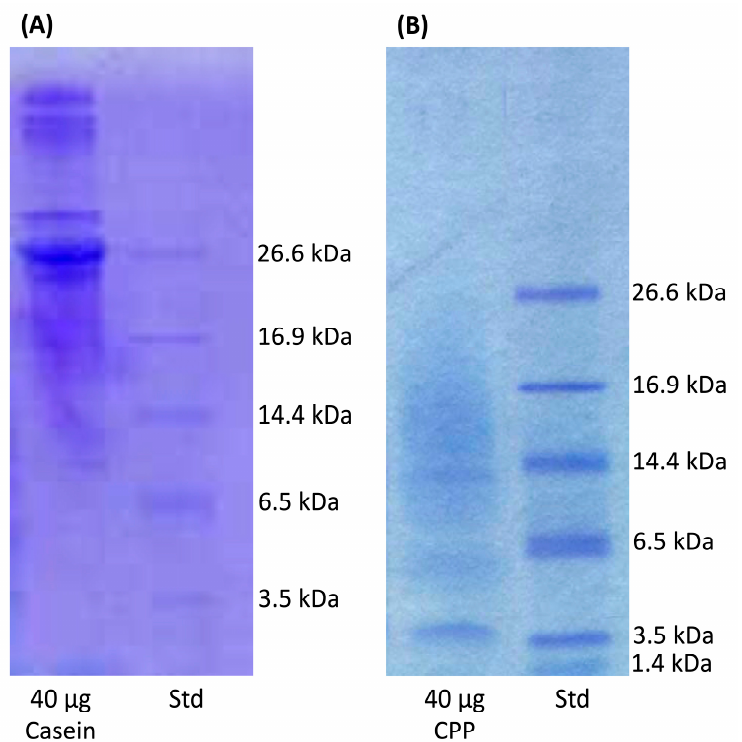
Figure 2. A 16.5% Tris-Tricine SDS-PAGE Gel stained with Coomassie G-250 using the Laemmli bu ff er system (1.0 M Tris, pH 8.45). Std, Polypeptide Standards. A comparison of ( A ) casein versus. ( B ) CPP is presented to the show CPP from the tryptic digested casein.